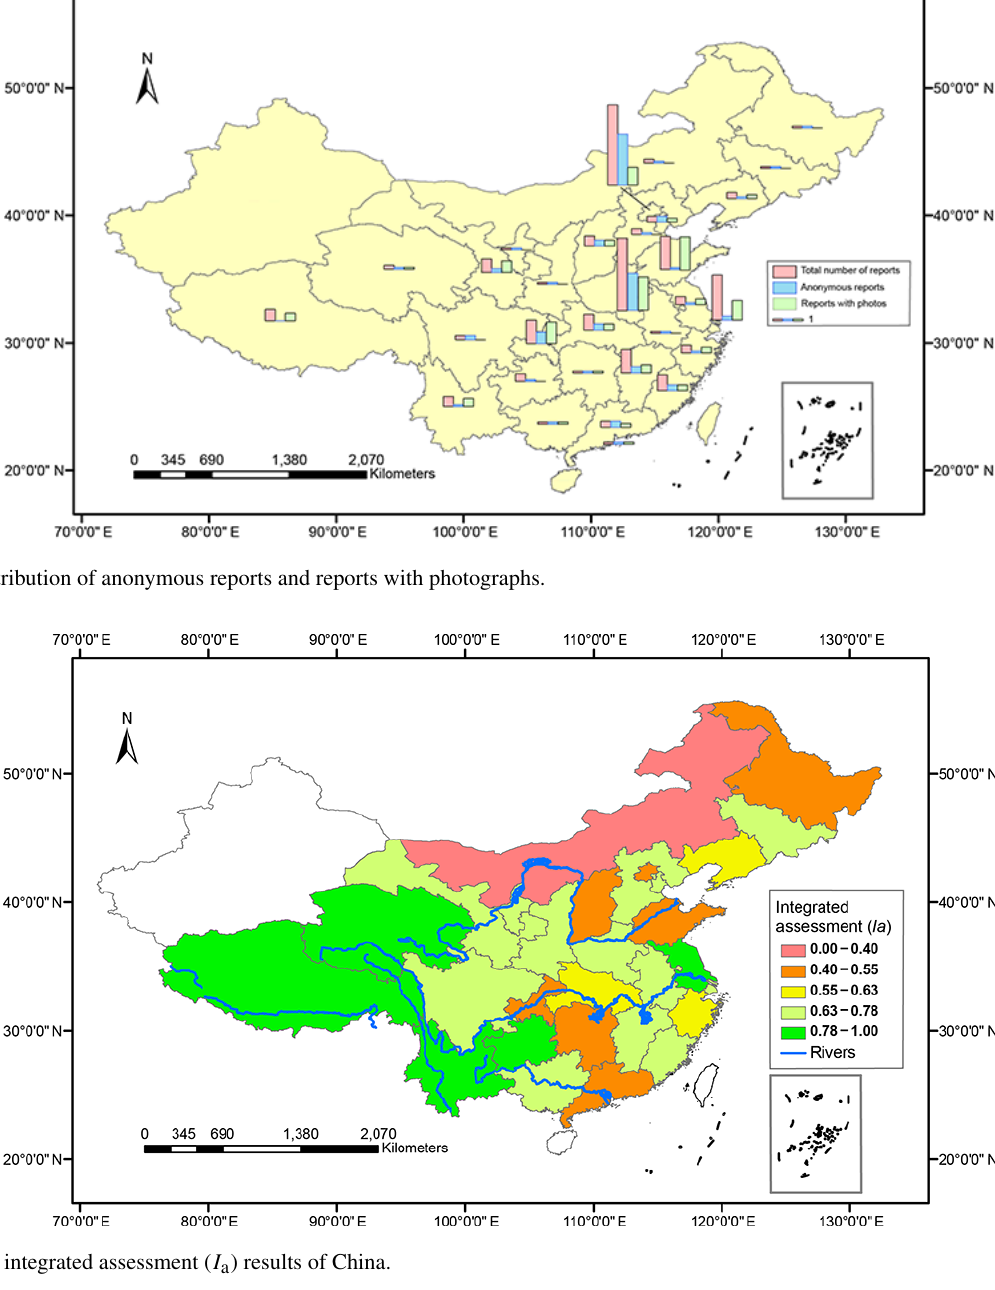
Figure 4. The integrated assessment ( I a ) results of